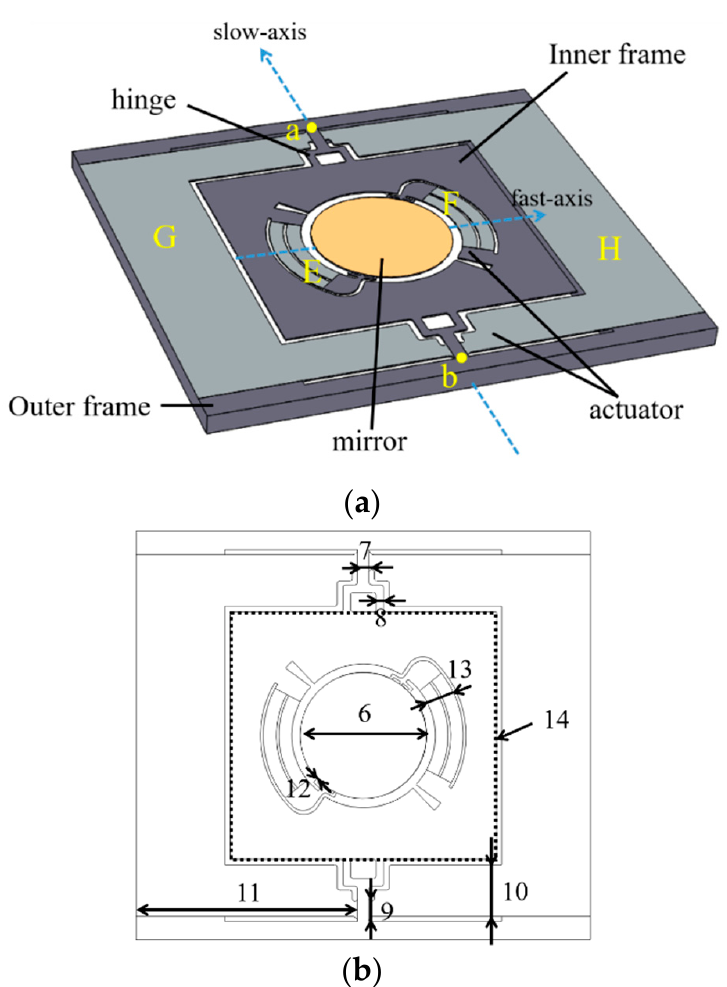
Figure 3. ( a ) The structure of Design II . ( b ) Design II parameter index . The frequency analysis was also performed utilizing Finite Element Simulation. In this work, mirrors with 3 mm and 1.5 mm aperture were designed to compare the per- formance of different aperture micromirrors and are referred to as Mirror II-1 and Mirror II-2 , respectively, and the optimized structure parameters are listed in Table 2. The basic settings of the simulation are the same as in Section 2.1. Mirror II-1 possesses a mirror diameter of 3 mm, a frame anchor width of 280 µ m, and a chip size of 10.8 mm × 8.6 mm. According to the simulation results in Figure 4, in Mirror II-1 , the first resonance frequency occurs at 913.2 Hz, where the inner frame including the mirror rotates along the slow axis. The piston mode frequency occurs at 1023.4 Hz, while the third resonance